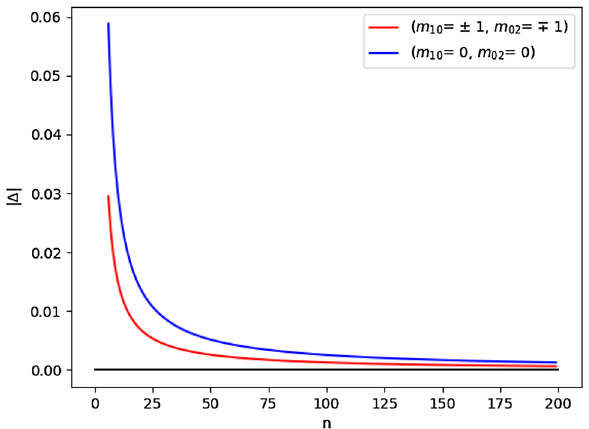
Fig. 5 The magnitude of the difference between the prediction yielded by Eq. (28) and that of QM, plotted as a function of the sequence length n , where | Δ | = | P ( m 10 , m 02 | j 10 , j 02 , j 12 , m 12 ) − (cid:9) j , j , m , m | j , j , J , M (cid:10) 2 | 1 2 1 2 1 2